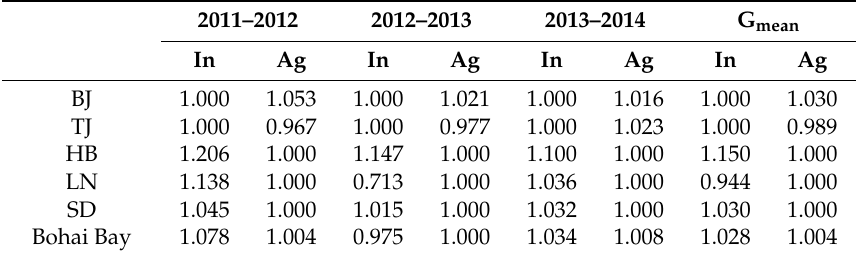
Table 8. EC components of NMWUPI of industry and agriculture,